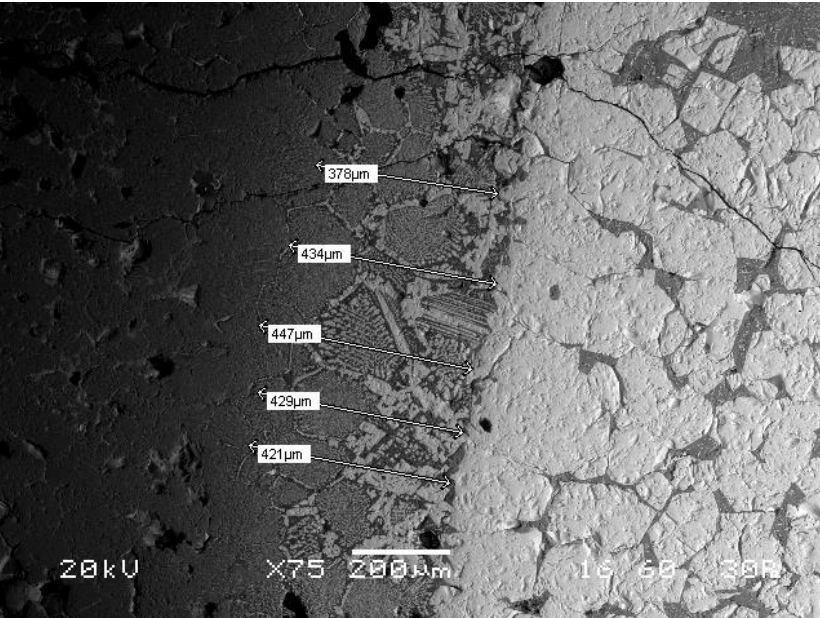
Figure 2. SEM image illustrating refractories ( left side ), the intermediate zone, and slag ( right side ). Average penetration depth: 421.8 µ m (experiment at temperature 1600 ◦ C and contact time 1 h).